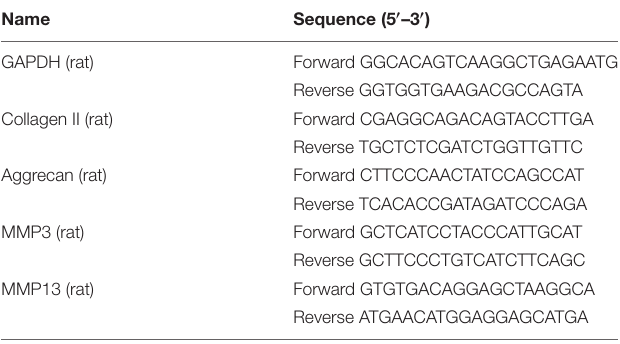
TABLE 1 | Sequences of primers used in the